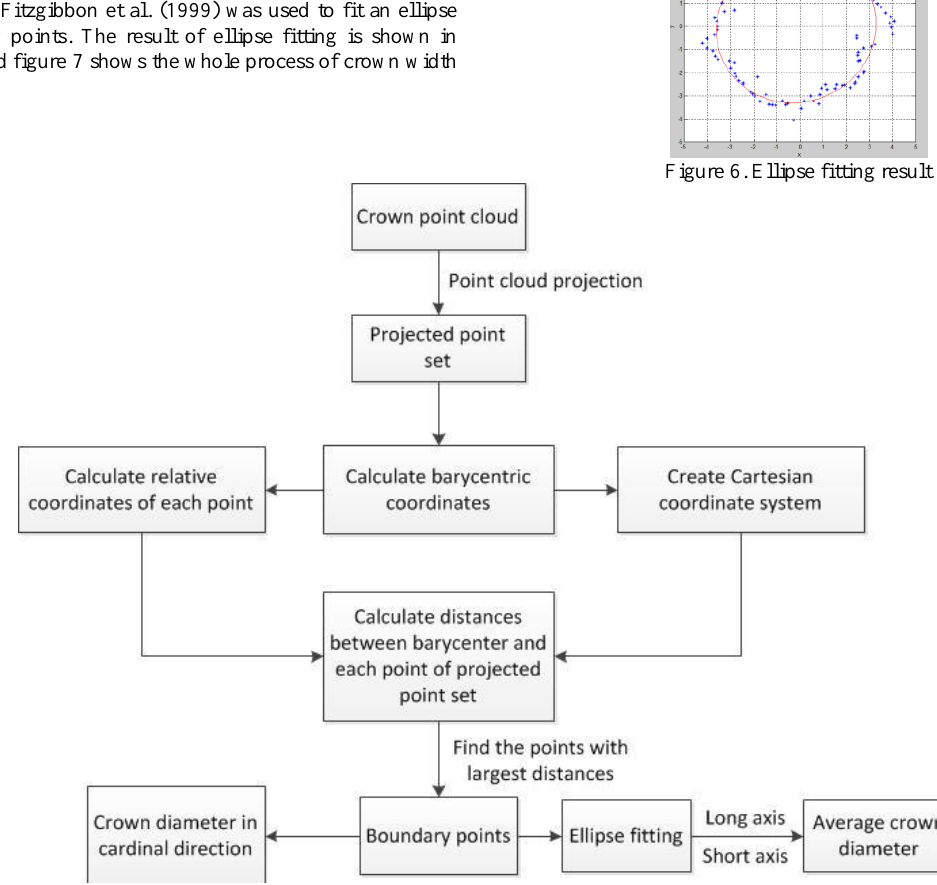
Figure 7. The work flow of crown width